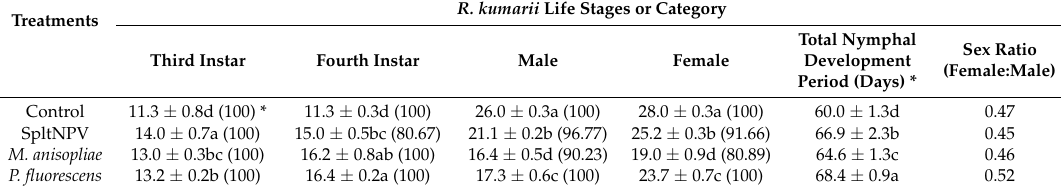
Table 4. Effect of Metarhizium anisopliae -, Spodoptera litura nucleopolyhedrovirus- (SpltNPV), and Pseudomonas fluorescens -treated and untreated Spodoptera litura prey consumed by R. kumarii nymphal stages and the total nymphal developmental period (days), survival rate (%), and the sex ratio of adult R. kumarii